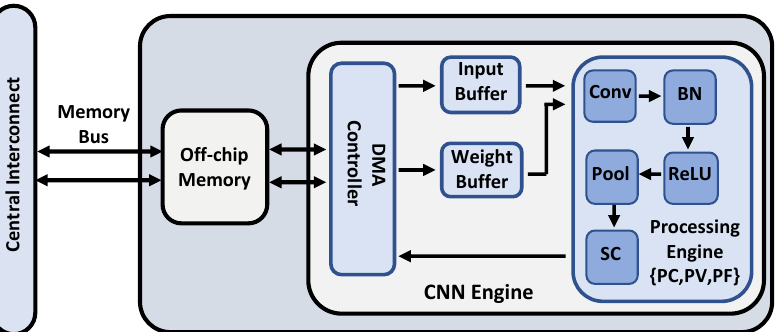
Figure 2. The convolutional neural network accelerator’s design. SC, shortcut; PC, channel paral- lelism; PV, vector parallelism; PF, filter parallelism; DMA, direct memory access.